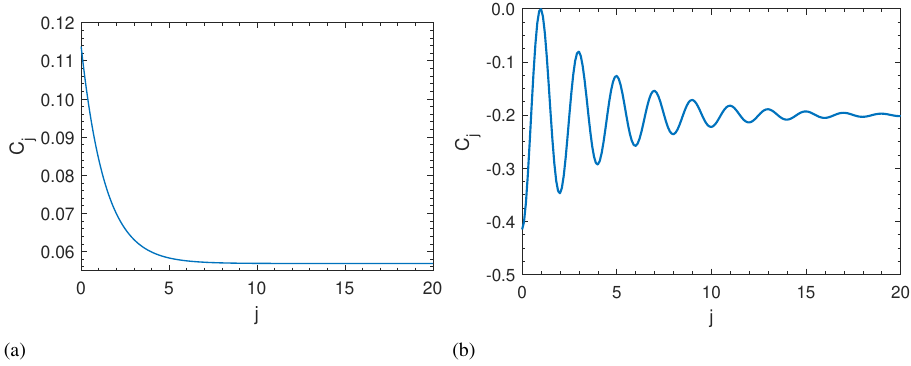
Figure 3. (a) C j plot for NBD at √ s = 7 TeV for pp collisions by taking p = 0.48, ¯ n = 25.5 and k = 1.45. This plot is clearly non-oscillating.(b) C j plot for GMD at √ s = 30.4 GeV for pp collisions by taking z = 3, ¯ n = 10.54, k = 4.78 and k ′ = 1.69. This plot clearly shows the oscillatory C ′